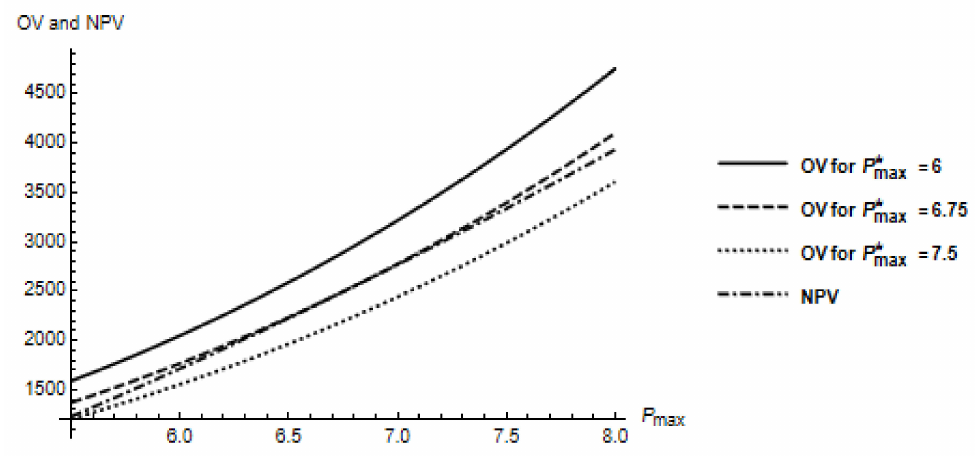
Figure 8. Option value to reinforce different values of P ∗ max ( t ) .